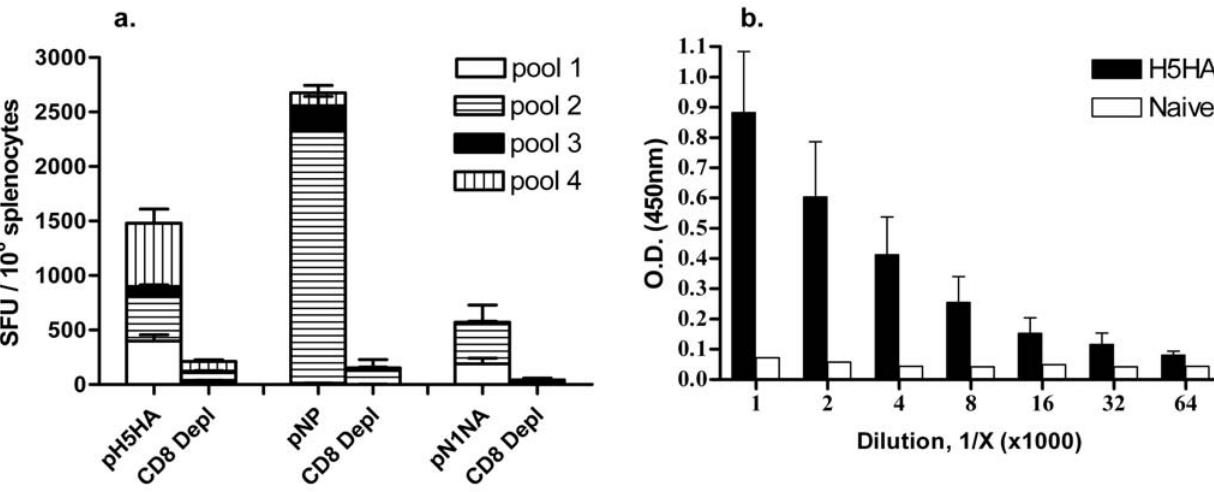
Figure 1. Induction of antigen-specific immune responses in BALB/C mice. (a) Quantification of IFN- c secreting CD8 + T cells at one month following the final immunization. Splenocytes were stimulated with pools of overlapping peptides spanning the length of the antigen, separated into multiple pools. Also included are CD8-depleted controls. (b) Endpoint antibody ELISA from serum collected from mice immunized with pH5HA. All error bars represent 6 1 standard deviation from the mean, and are representative of three independent experiments.